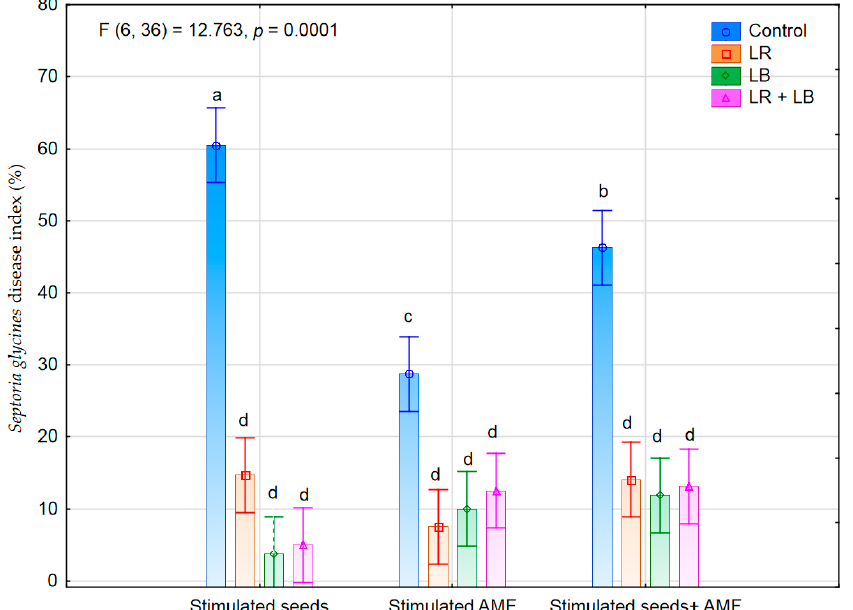
Figure 6. Septoria glycines disease index (%) on the aboveground parts of soybean plants grown from seeds treated with arbuscular mycorrhizal fungi (AMF) and LR—helium-neon laser (red light), LB— argon laser (blue light), and LB + LR—Ar laser, followed by He ‐ Ne laser. Different letters indicate the significant differences at p < 0.05.